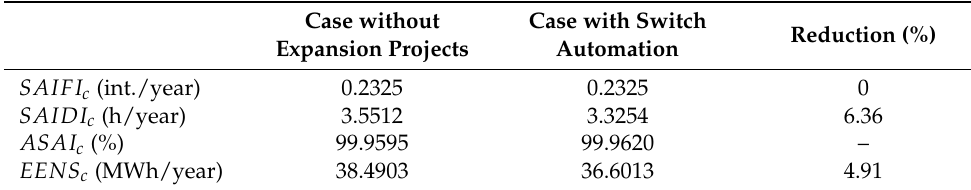
Table 9. Impact of automation with switches on reliability